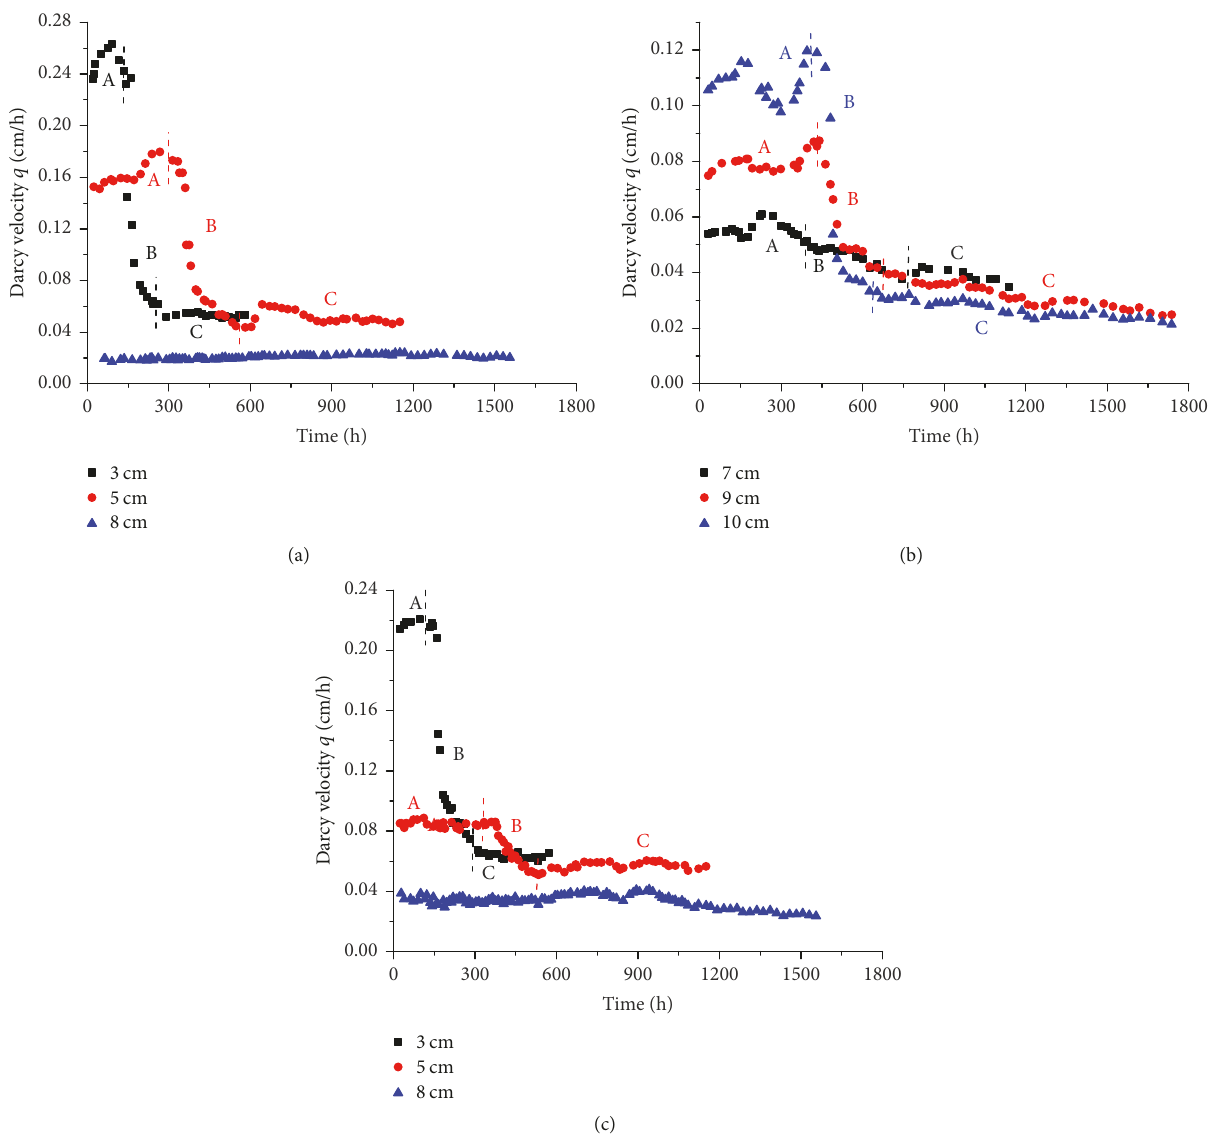
Figure 2: Darcian velocity versus time for three column experiments: (a) smooth wall soil columns with the same inner diameter (14cm) but different lengths; (b) smooth wall soil columns with the same column length (5cm) but different column inner diameters; (c) rough wall soil columns with the same inner diameter (14cm) but different column